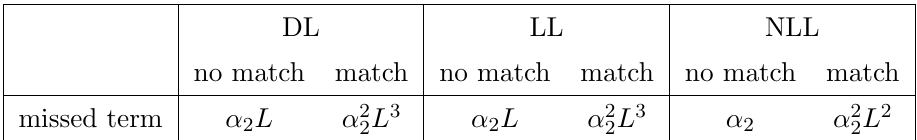
Table 3 . Scaling of the dominant missed term in the perturbative expansion, for the double log expansion, where only the leading (cid:11)L 2 term in the exponent is kept, the LL expansion, where the whole function g 1 ( (cid:11)L ) is kept, and the NLL expansion, where the functions g 1 ( (cid:11)L ) and g 2 ( (cid:11)L ) are kept. For each of these, we show the scaling of the (cid:12)rst missed term if just the logarithmic resummation is used, and also the scaling if the resummed result is matched with the (cid:12)xed order NLO calculation (such that the full (cid:11) dependence is